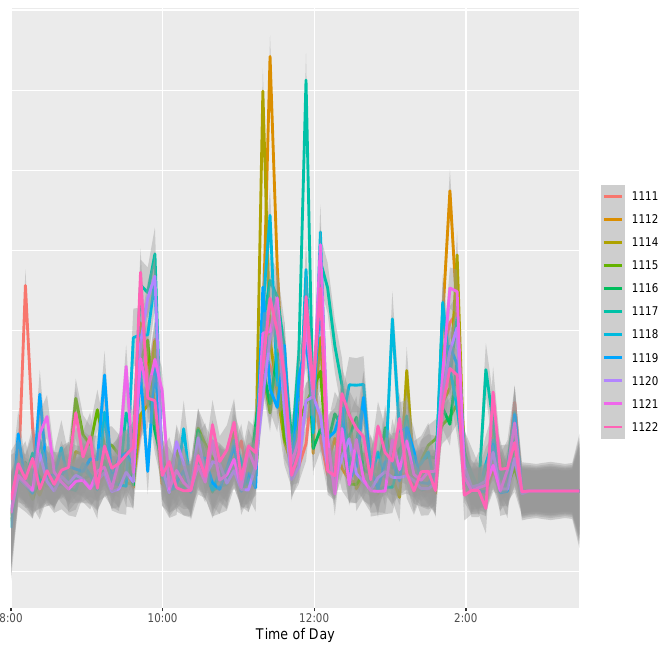
Figure 7. First column of daily activity for 11 subjects across four weeks.